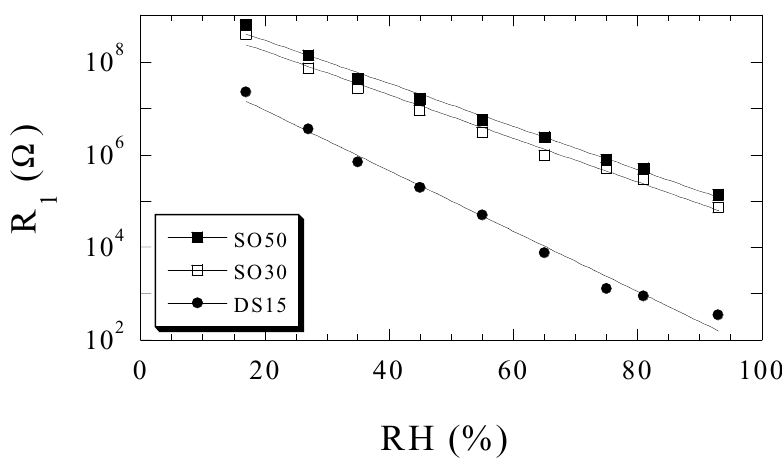
of different sensors obtained by fitting the 1